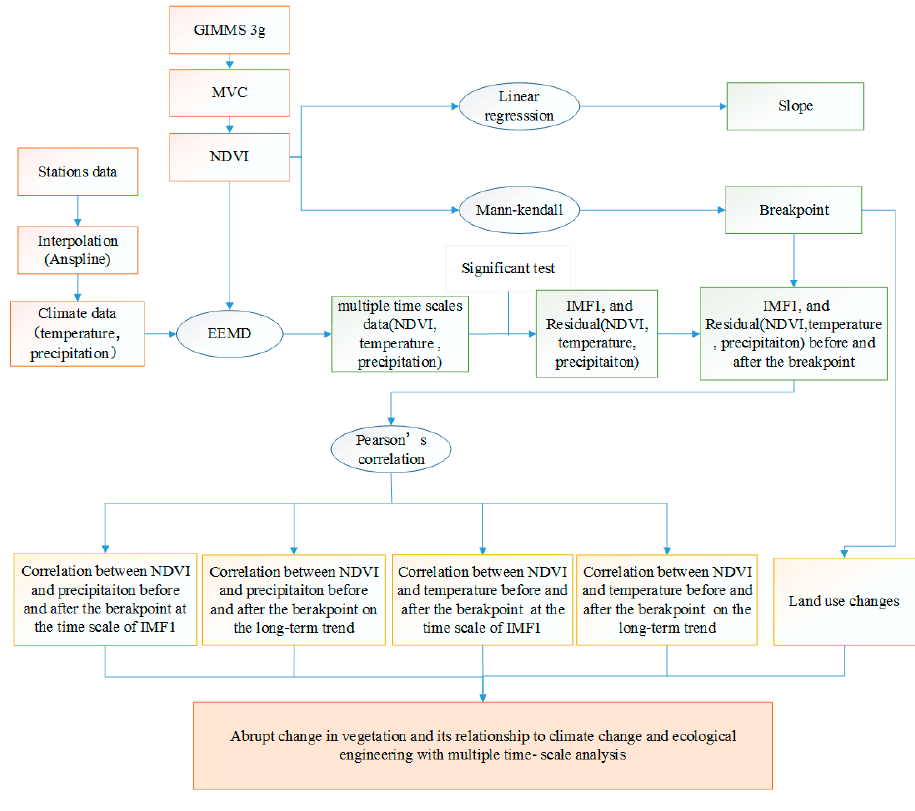
Figure 2. A workflow of the research method process.